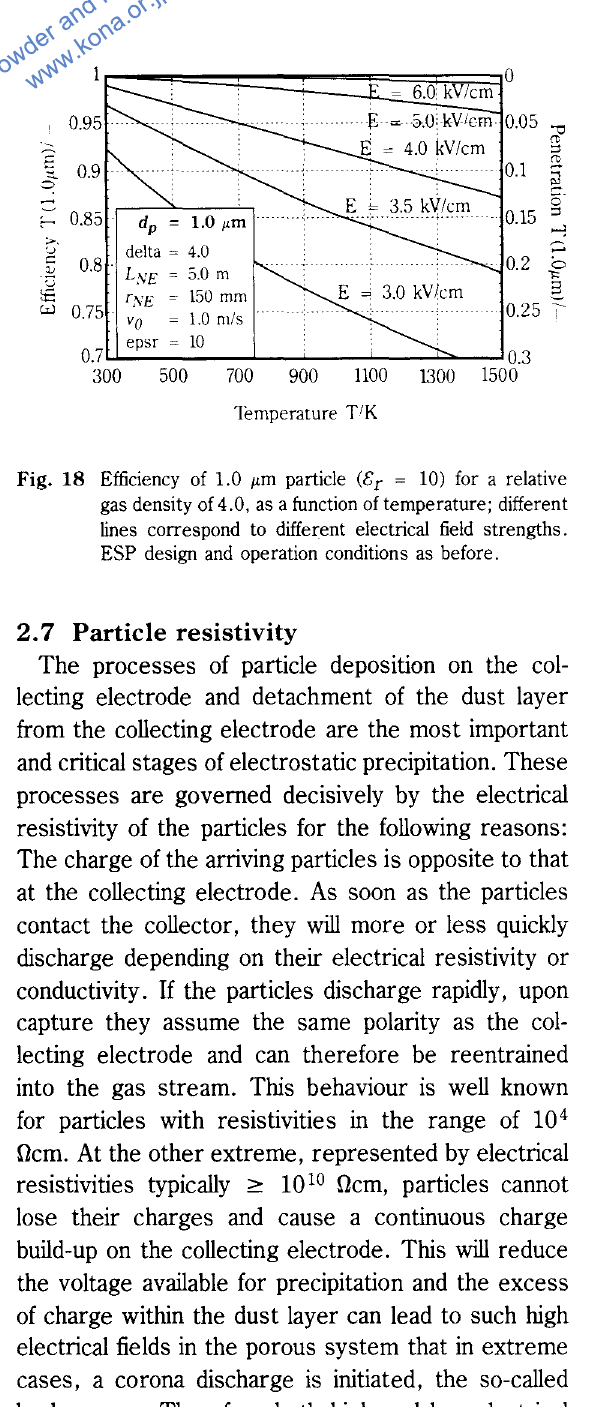
Fig. 19 Electrical resistivity of cement kiln dust as function of temperature (taken from (2)); curves demonstrate the effectiveness of moisture